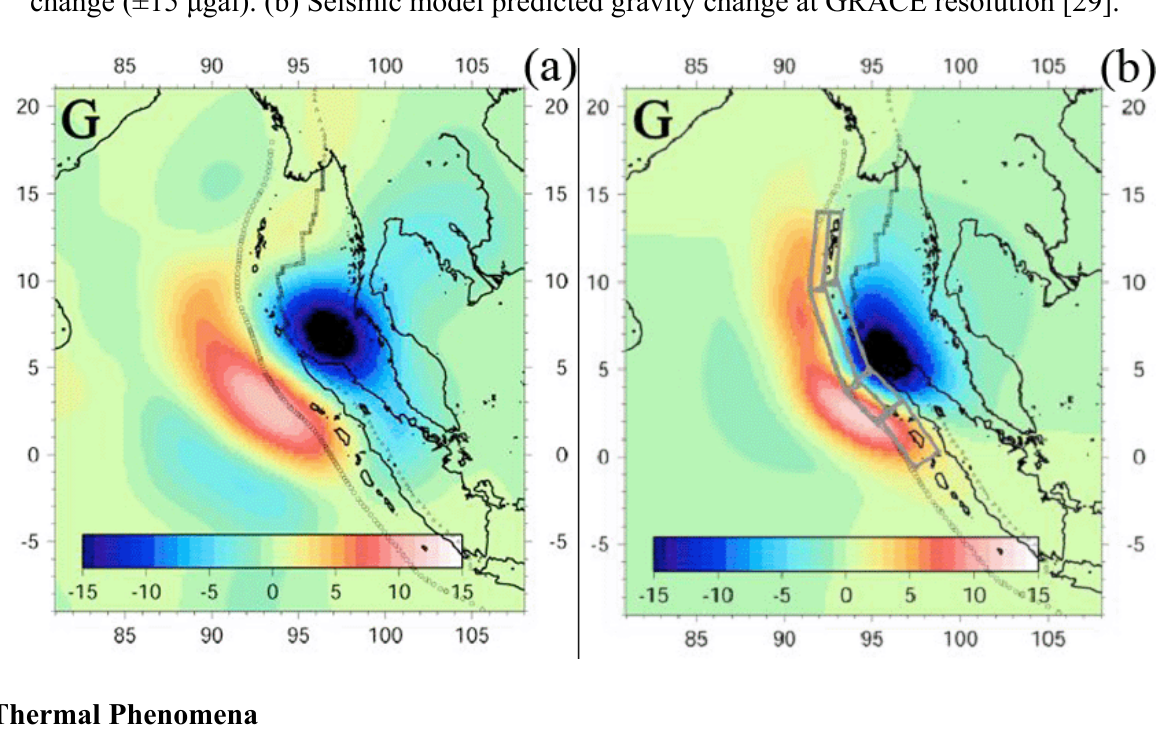
Figure 12. Satellite data showing the gravity changes for the Sumatra earthquake (M = 9.0, 26 December 2004, Indonesia). ( a) A composite image from GRACE observed gravity change (±15 μ gal). (b) Seismic model predicted gravity change at GRACE resolution